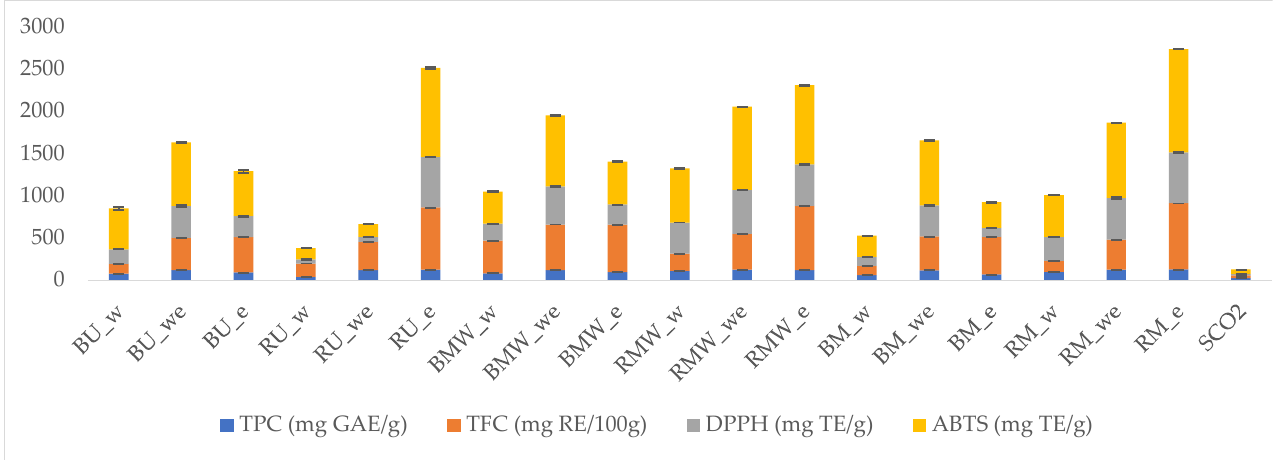
Figure 4. Total phenolic, flavonoid content, and free radical scavenging abilities of the tested extracts. Values are reported in Table S2. Data are expressed as Gallic acid equivalents (GE) Rutin equivalents (RE) and Trolox equivalents (TE).